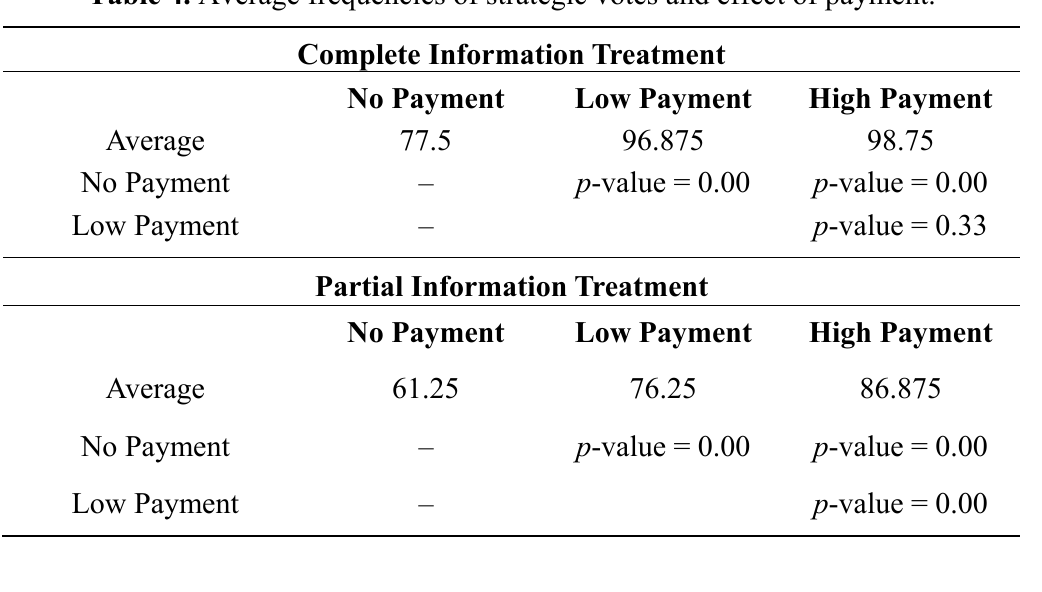
Table 4. Average frequencies of strategic votes and effect of payment.